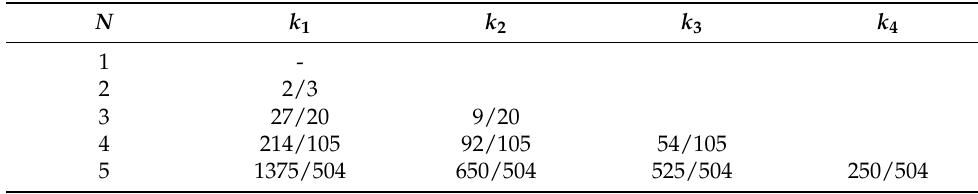
Table 1. Coning error compensation coefficient for 1–5